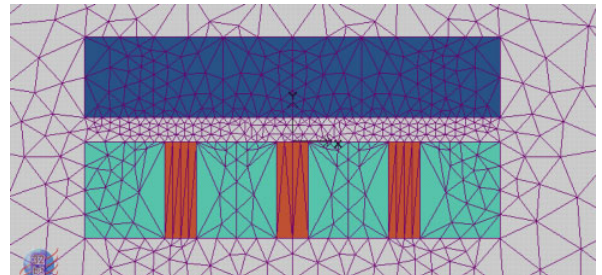
Figure 17 The mesh of the models.